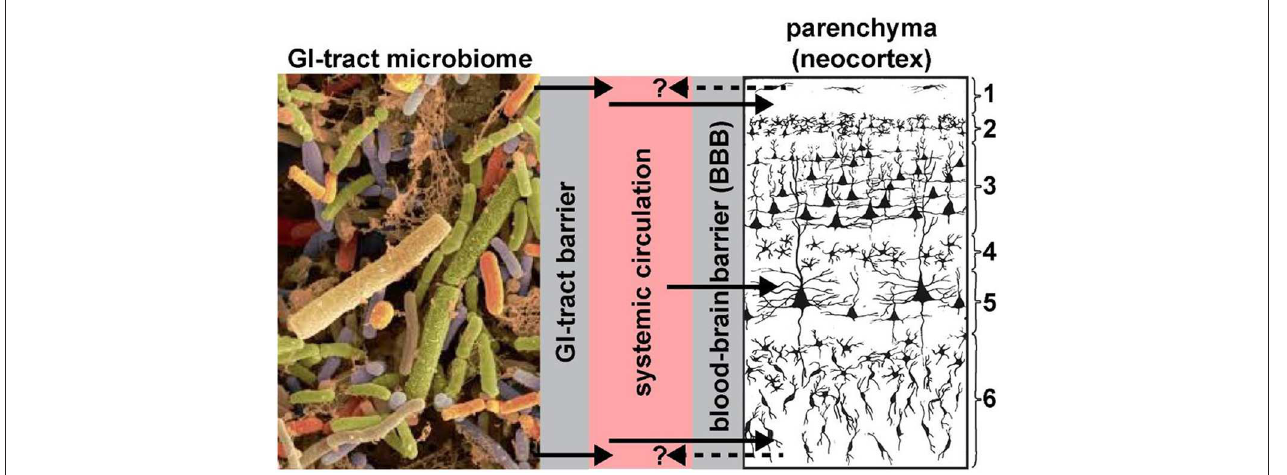
FIGURE 1 | Highly schematicized depiction of the potential transfer of GI-tract microbiome-derived pro-inflammatory neurotoxins across the GI-tract barrier into the systemic circulation, followed by translocation across the BBB into the brain parenchyma (see Hill et al., 2014a,b; Hill and Lukiw, 2015; Zhao and Lukiw, 2018a; neocortical region shown; solid black arrows). Neurotoxins identified to date include Bacteroides fragilis lipopolysaccharide (BF-LPS) and enterotoxins such as the Bacteroides fragilis -derived toxin (BFT) also known as fragilysin . The contribution of other pro-inflammatory neurotoxins such as GI-tract-derived amyloids and bacterial sncRNAs are not well-understood and currently very little is known concerning their neurotoxicity and CNS-effects. BF-LPS, BFT ( fragilysin ), age, dietary toxins, traumatic brain injury (TBI) and vascular disease are known to effectively disrupt endothelial cell-based biophysical barriers in part through the cleavage, disruption and/or degeneration of cell-cell adhesion proteins (Wu et al., 1998; Clement et al., 2016; Zhao and Lukiw, 2018a,b; Sweeney et al., 2019). We speculate that all of these neurotoxins together have potential to constitute a highly neurotoxic pro-inflammatory GI-tract microbiome-derived cocktail greatly detrimental to the cytoarchitecture and signaling functions of neuronal and glial cells. Gram-negative bacterial-derived LPS and related neurotoxins have been recently observed within the systemic circulation and brain parenchyma (Zhan et al., 2016, 2018; Zhao et al., 2017a,c, 2019; Zhao and Lukiw, 2018a), within and around neurons, and in the later stages of AD completely encapsulating neuronal neocortical nuclei (Hill et al., 2014b,a; Hill and Lukiw, 2015; Zhao and Lukiw, 2018a,b; unpublished observations); this later action appears to impair the exit of neuron-specific transcripts such as the neurofilament-light (NF-L) chain and synapsin-2 (SYN2) messenger RNA (mRNA) from the neuronal nuclei; both NF-L and SYN2 mRNA abundance and expression are down-regulated in LPS-treated human neuronal-glial (HNG) cells in primary culture and in AD brain (Lukiw et al., 2018; Zhao et al., 2019). Whether neurotoxins from the brain parenchyma of the neocortex can cross the BBB back into the systemic circulation (dashed black arrows with question mark) is currently not well-understood; if so, these species may be useful serum biomarkers for both the diagnosis and prognosis of AD and other types of inflammatory neurodegeneration; left panel = GI-tract microbiome magnification x ∼ 3000 (source: http://www.Injnbio.com; http://www.lnjnbio.com/nd.jsp?id=20; permission to reproduce granted; last accessed 26 November 2019); right panel = 6-layered structure of the human association neocortex; layers 3 and 5 are the pyramidal cell layers targeted by the AD process; other brain regions may also be affected; magnification x ∼ 20 (source: adapted and redrawn from Martinez-Conde, 2018; last accessed 26 November 2019).